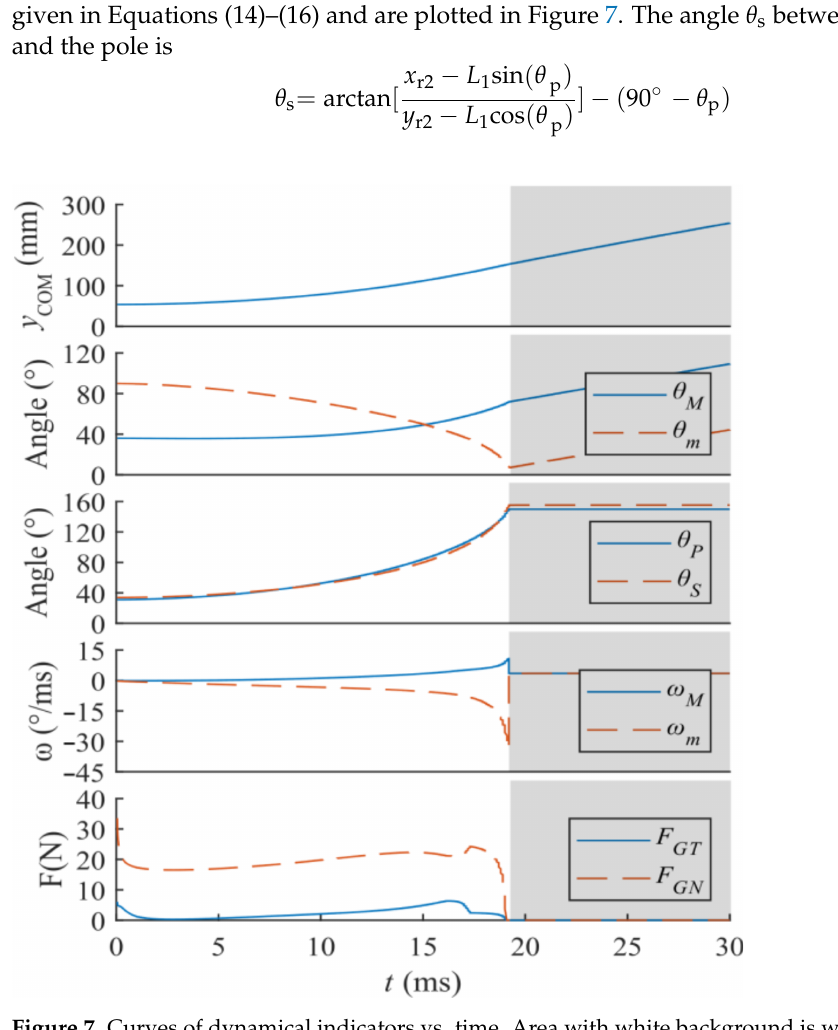
Figure 7. Curves of dynamical indicators vs. time. Area with white background is when mechanism is in contact with the ground. Area with gray background is when mechanism is in the